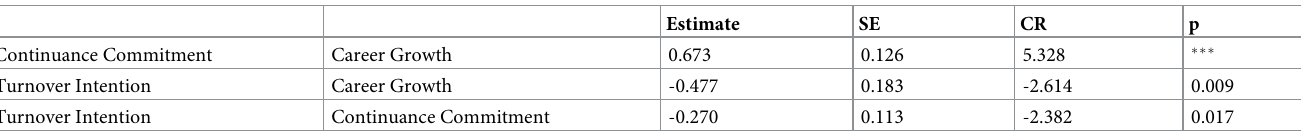
Table 14. Regression